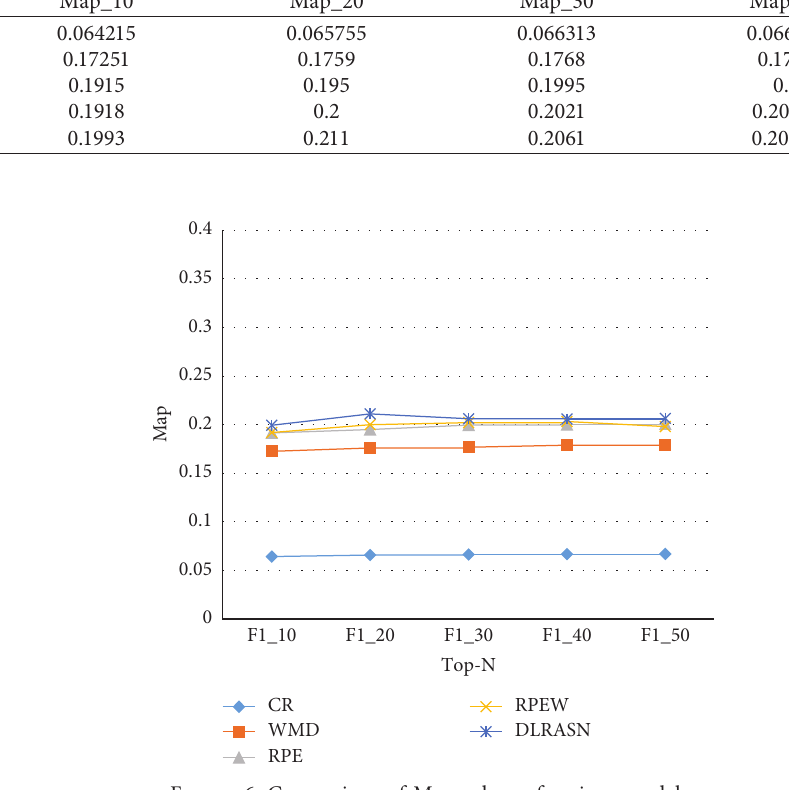
Figure 6: Comparison of Map values of various